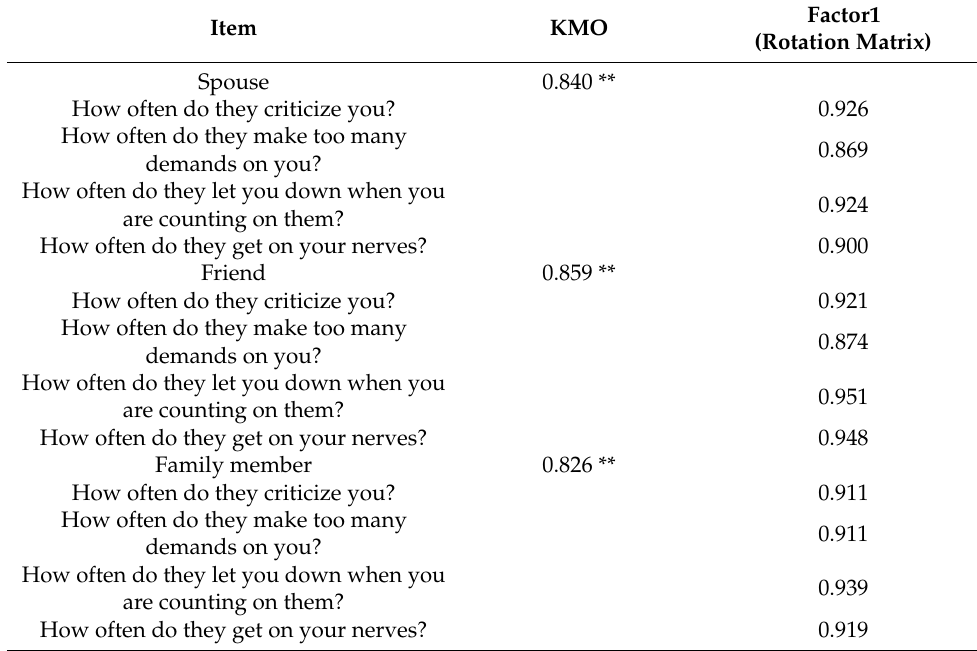
Table 3. KMO and factor analysis of items in each subscale of NRQ-INA questionnaire.